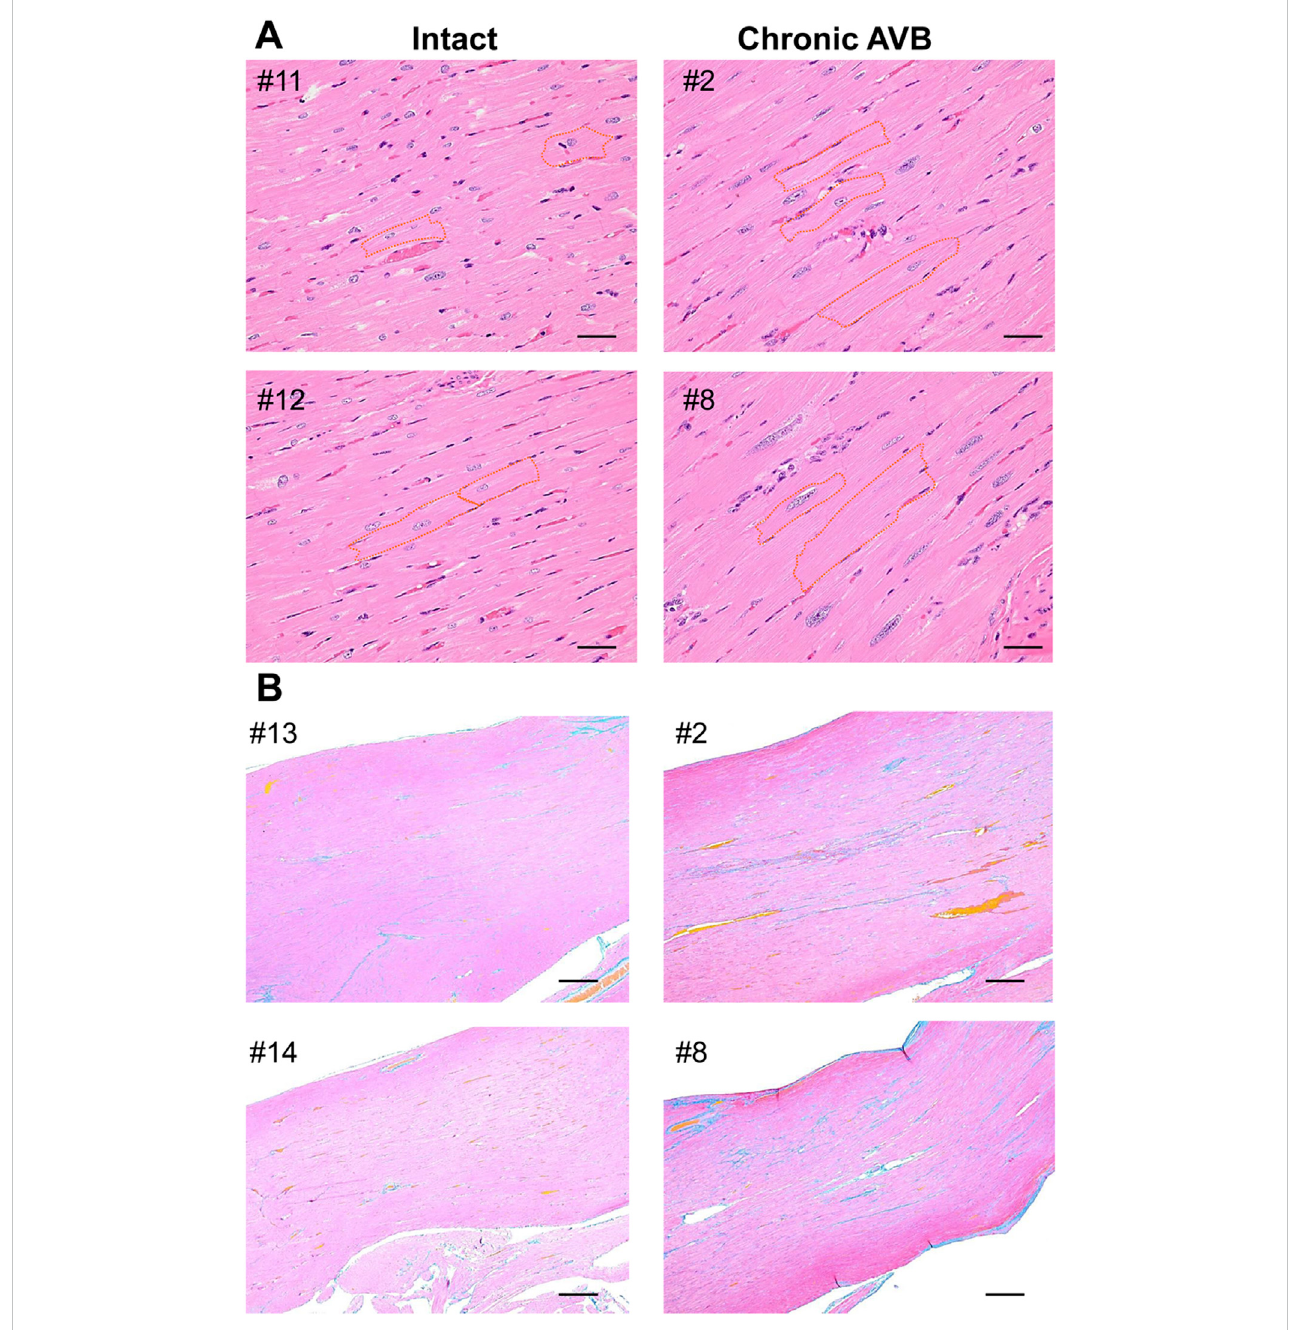
FIGURE 6 Microscopicphotosofthefreewallsoftheleftventricleobtainedfromintactanimals(#11,#12,#13,#14,left)(Intact)and#2and#8animalsat8 months after the onset of atrioventricular block (Chronic AVB, right), which were stained with hematoxylin-eosin staining (A) and Azan (B) . Orange broken lines in panel A indicate outlines of cardiomyocytes. Scale bars: 20 μ m (A) and 200 μ m (B)